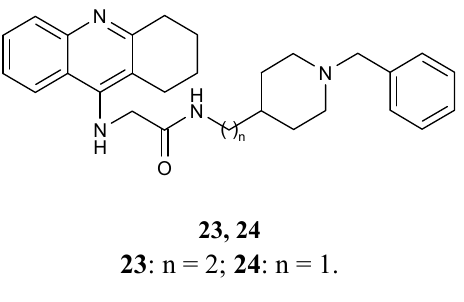
Figure10. Tacrine-donepezil hybrids 23 , 24 .